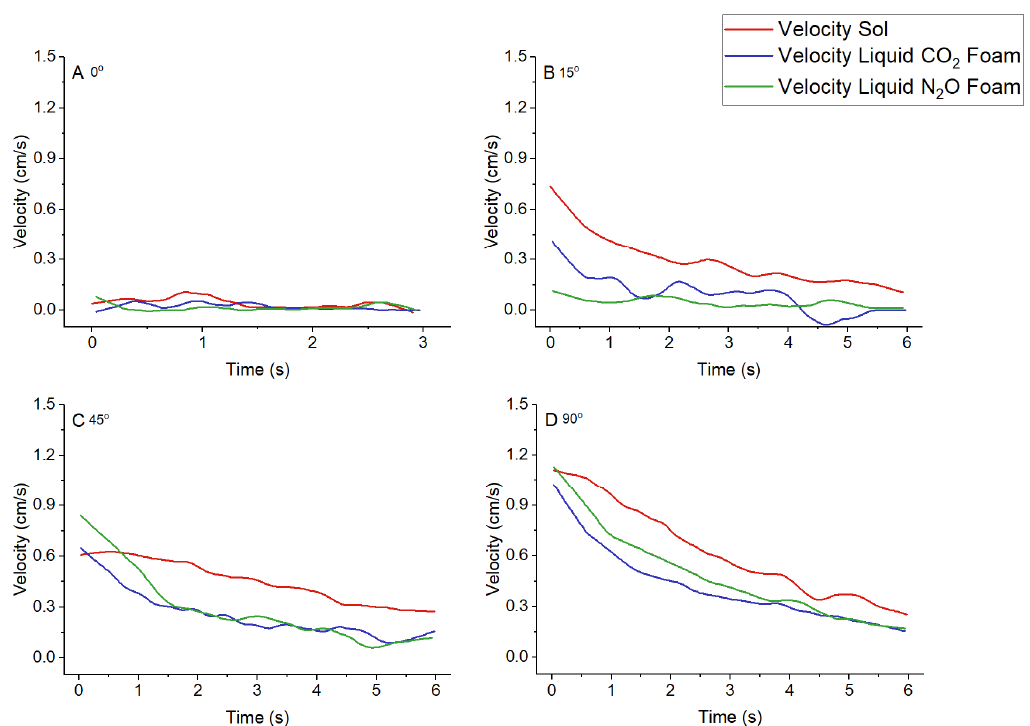
Figure 4. Behavior of the velocity front of the three fluid agar systems deposited onto a gypsum surface at different degrees of inclination ( A ) 0°, ( B ) 15°, ( C ) 45°, ( D ) 90°.